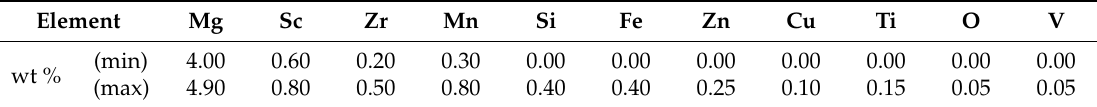
Table 2. The chemical composition of Scalmalloy ®